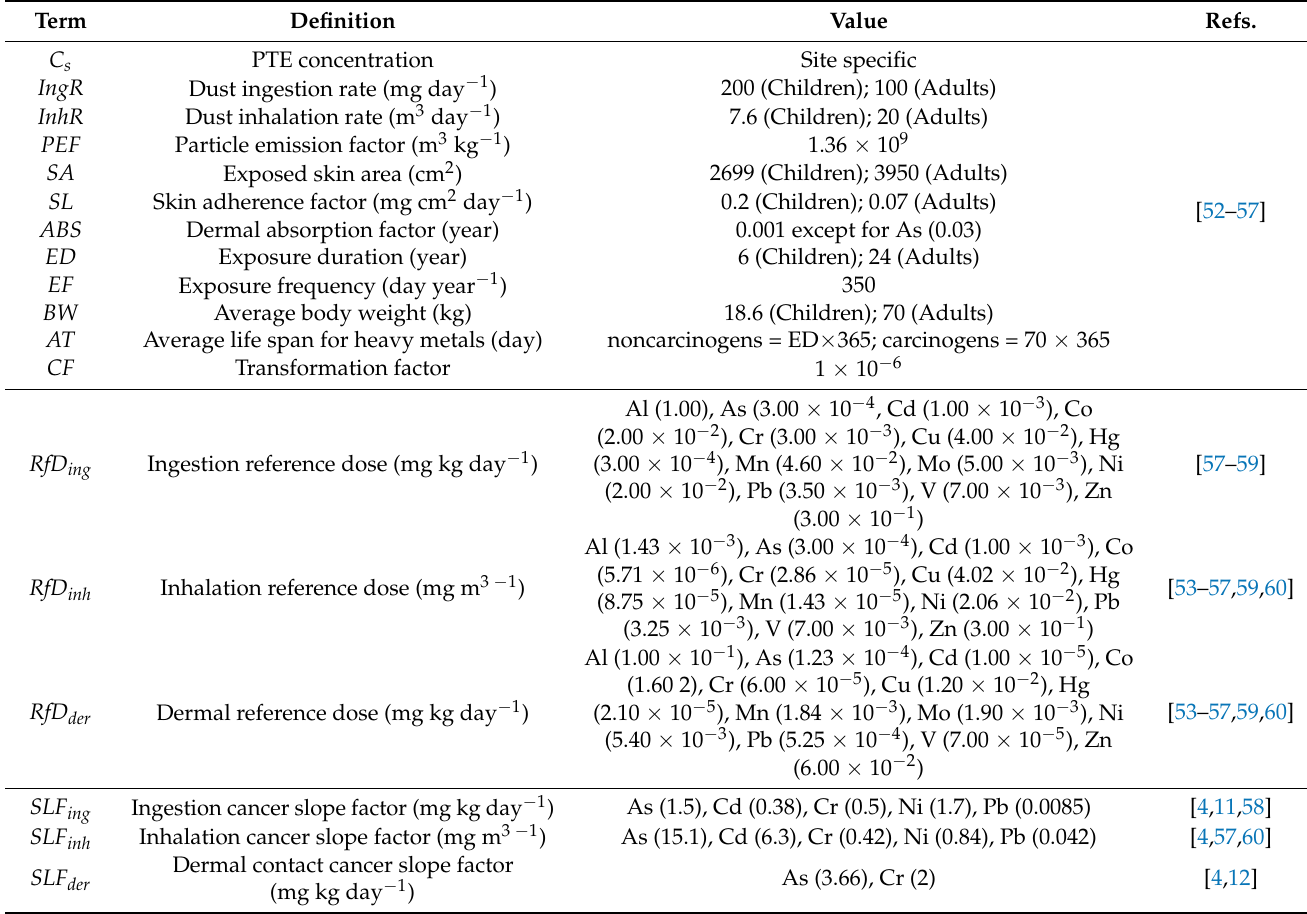
Table 1. Definitions and reference values of human health risk